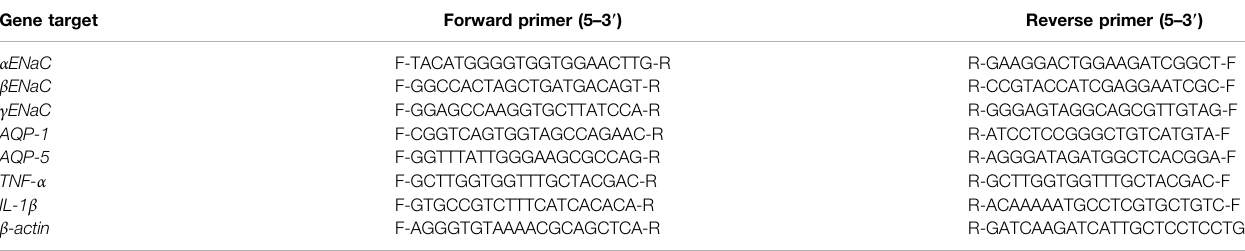
TABLE 3 | PCR primers for different observation